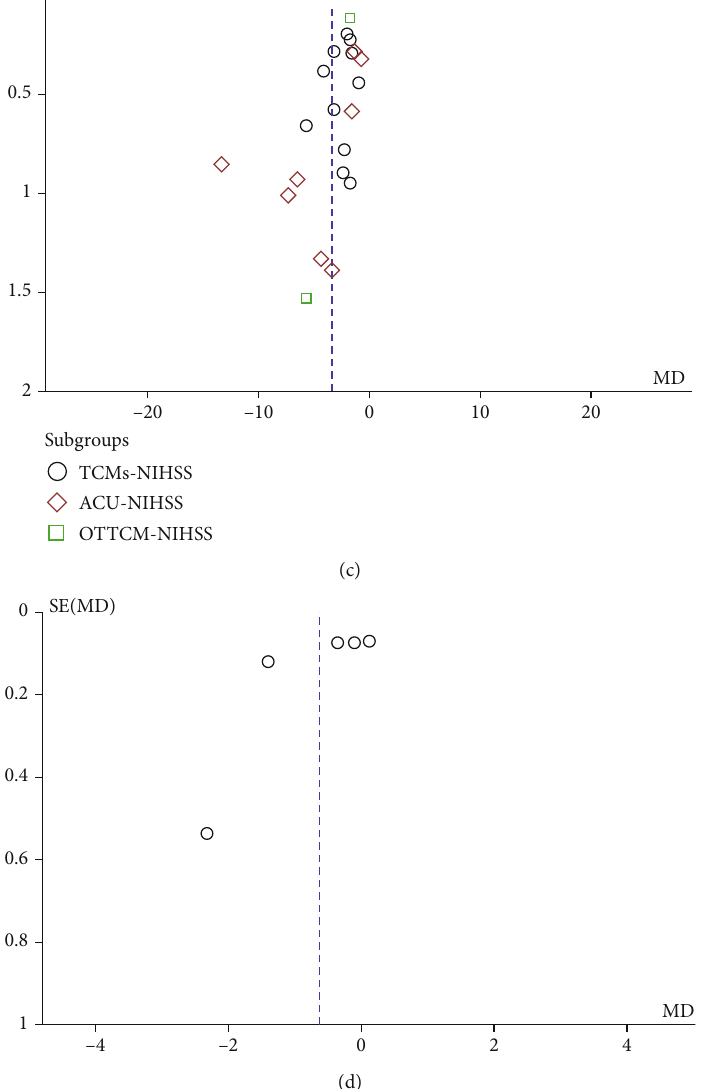
Figure 13: Funnel plot for the publication bias. (a) The plot of TER, (b) the plot of BI, (c) the plot of NIHSS, and (d) the plot of hs-CRP. The funnel plots of these factors were generally symmetrical, indicating that there is no obvious publication